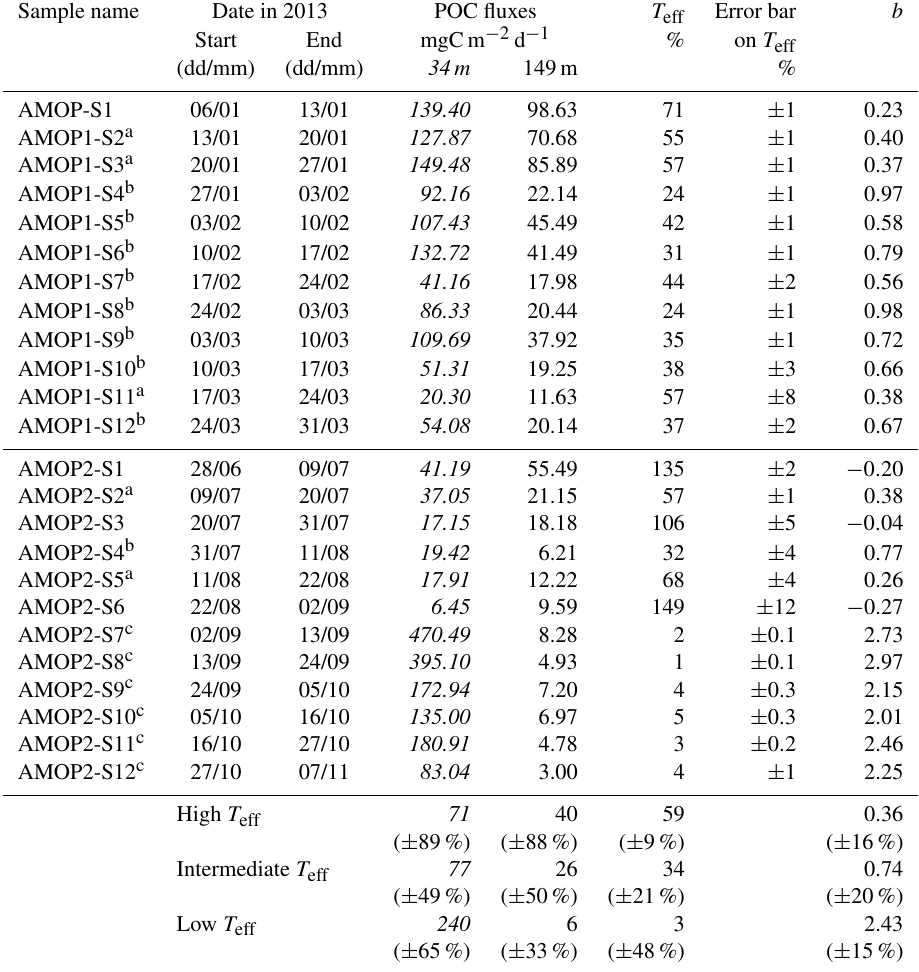
Table 1. POC flux, transfer efficiency T eff and b for each main T eff range. T eff is determined from the %Flux 149m / Flux 34m ratio and is given as a percentage (Eq. 1). b is the coefficient from the Martin’s curve theory (Suess, 1980; Martin et al., 1987). Italic and non-italic values correspond to the fluxes at 34 and 149m, respectively. In the last lines of the table, POC fluxes, T eff and b are averaged for low, intermediate and high T eff , respectively, with the relative standard deviation among samples ( ± SD%). Analysis accuracy on the POC fluxes is ± 0 . 2%, inducing an absolute uncertainty on its vertical transfer efficiency estimated from a logarithmic expansion of ± 0 . 2% (see Sect.